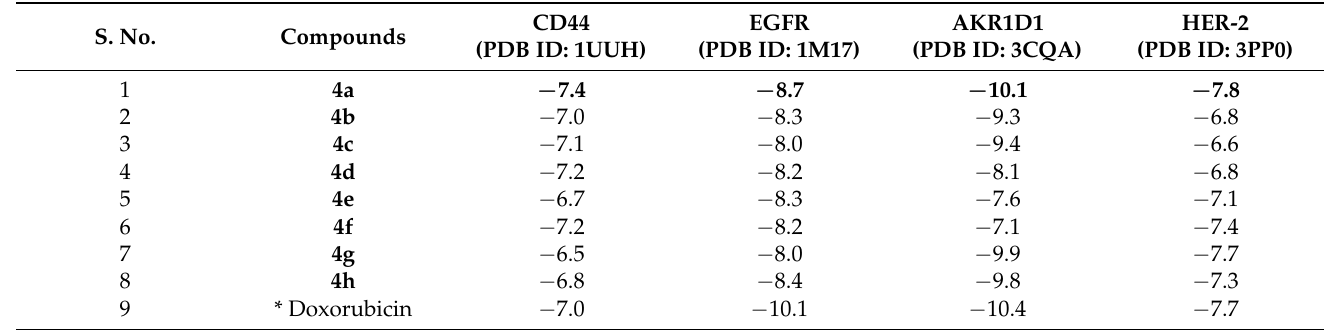
Table 3. PyRx-based screening of substituted SOXs ( 4a – h ) against CD44, EGFR- Tyrosine kinase domain, 5- β -reductase (AKR1D1), and HER-2.